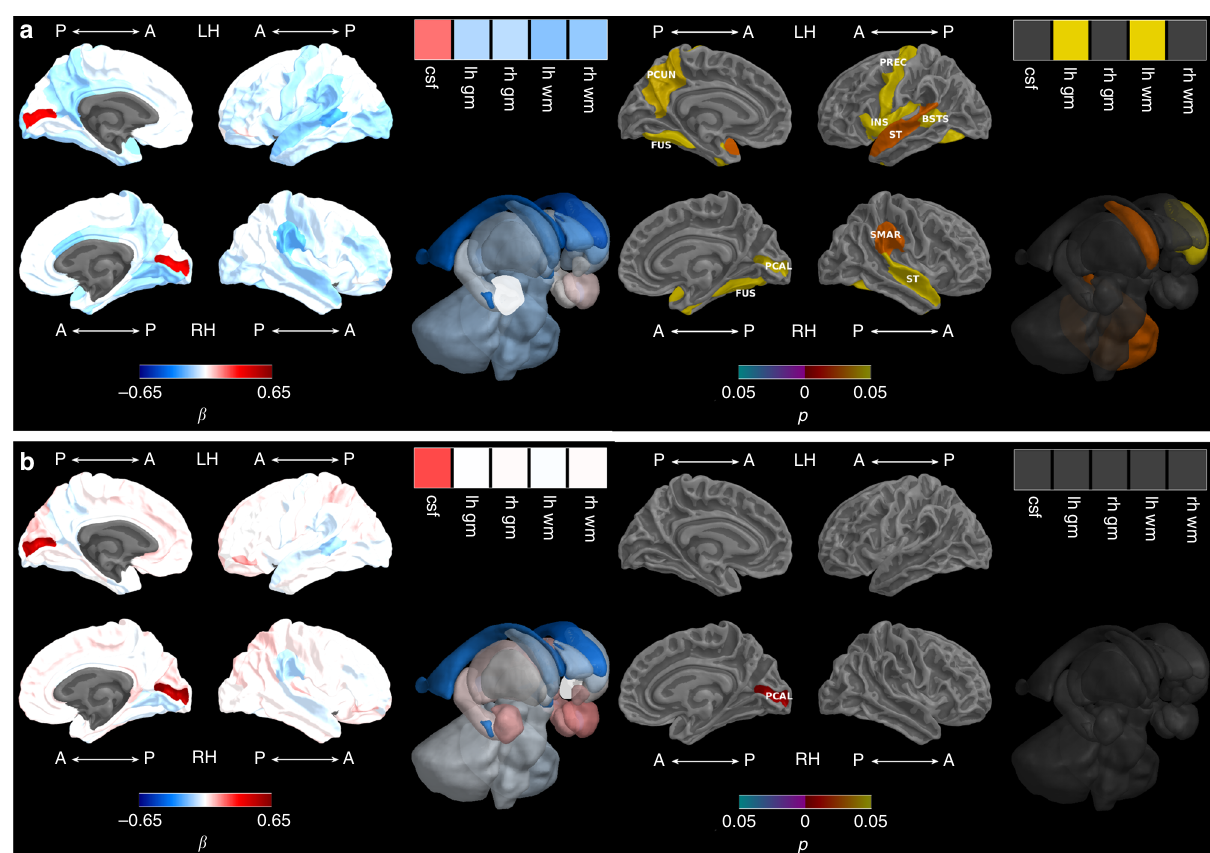
Fig. 2 Brain abnormality and brain growth from term-equivalent to 7 years. a Before and b after adjusting for total brain volume. Note: Brain abnormality- by-time regression coef fi cients from linear mixed effects models ( β ) in blue refer to negative associations (slower growth in children with brain abnormality compared with children with no or mild brain abnormality) and in red refer to positive associations (faster growth in children with brain abnormality compared with children with no or mild brain abnormality), with darker coloured regression coef fi cients indicating stronger associations; Interaction p values are false discovery rate corrected and darker coloured p values indicate stronger signi fi cance; Boxes in the top right corner of the fi gures represent global brain volumes. A = anterior, P = posterior, LH = left hemisphere, RH = right hemisphere, csf = cerebrospinal fl uid, gm = grey matter, wm = white matter, BSTS = banks of superior temporal sulcus, FUS = fusiform, INS = insula, PCAL = pericalcarine, PCUN = precuneus, PREC = precentral, ST = superior temporal, SMAR =